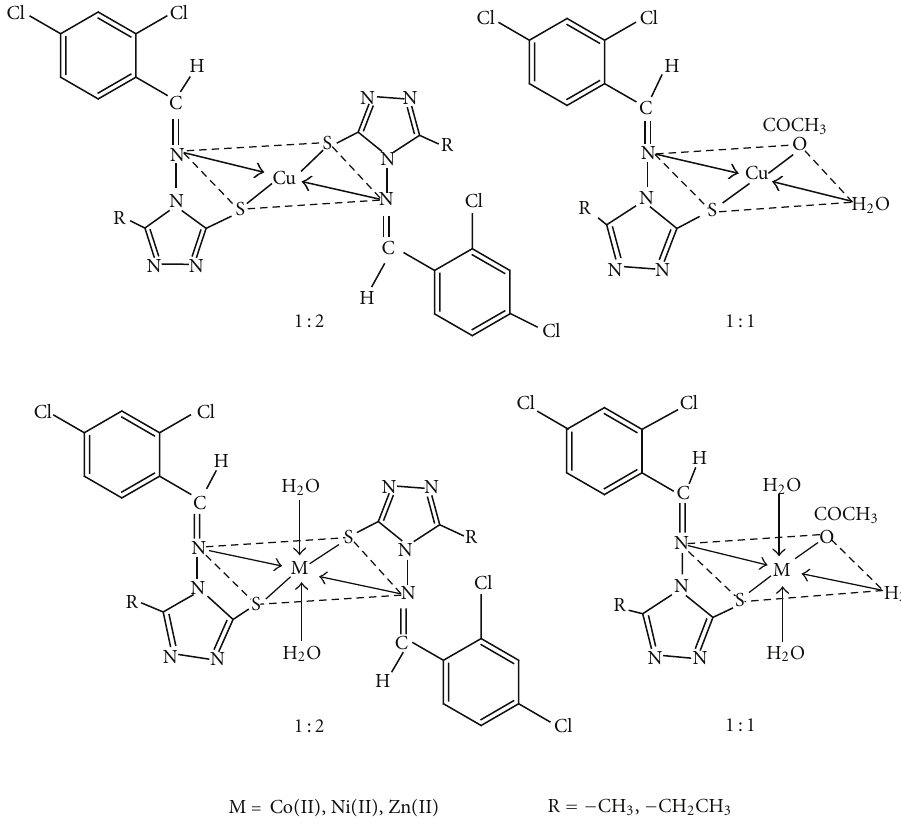
Figure 4: Structures of metal